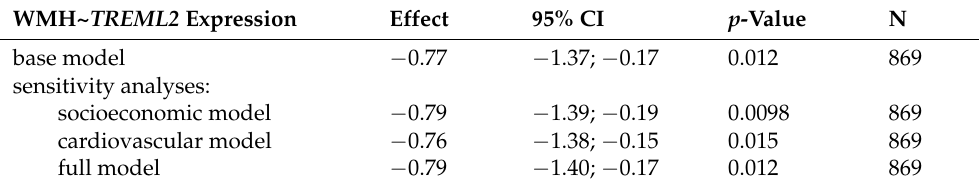
Table 2. WMH volume associates with TREML2 expression. The base model has been adjusted for general participant data (age, sex, age × sex, ICV), blood parameters (wbc, rbc, plt, neutrophils, monocytes, basophils, eosinophils) and technical parameters (RIN, amplification batch, sample storage time). The socioeconomic model has additionally been adjusted for education, income, alcohol intake and partner status. The cardiovascular model is the base model with an additional adjustment for BMI, smoking status, hypertension, serum total/hdl cholesterol ratio and triglycerides. The full model is the base model with additional adjustment for all socioeconomic and cardiovascular factors. WMH~ TREML2